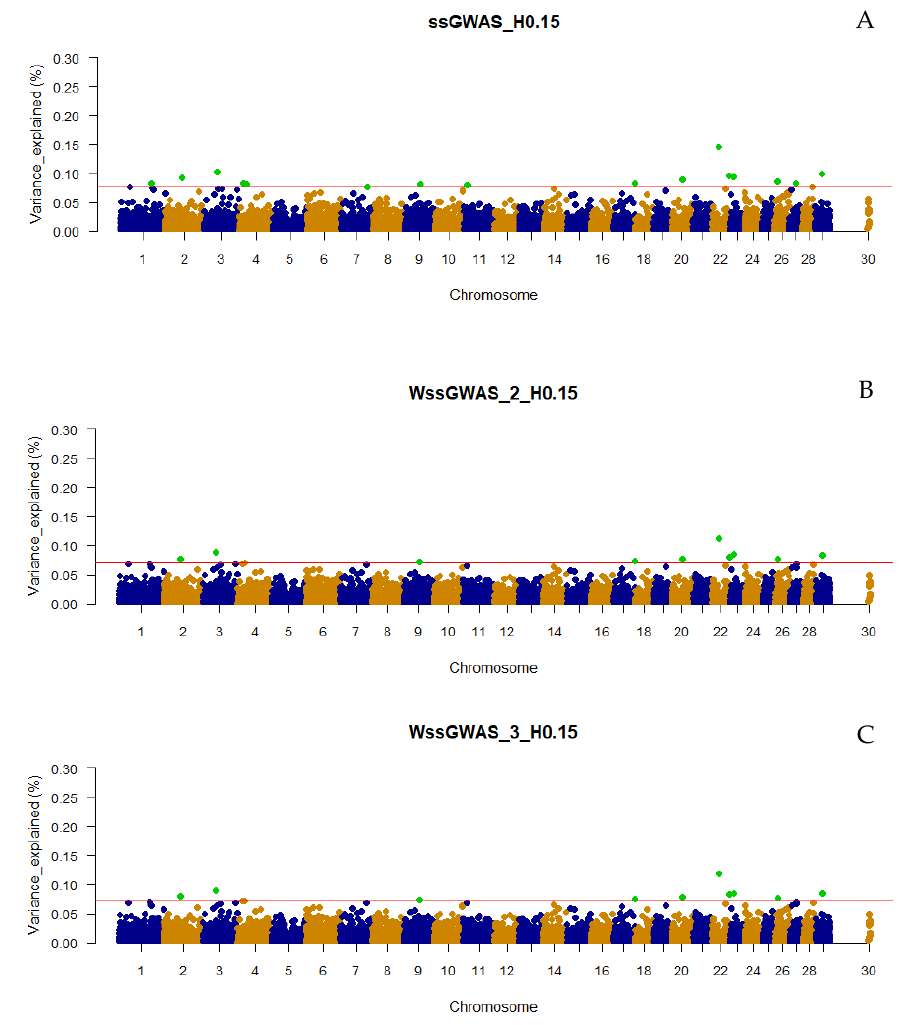
Figure 2. Manhattan plot of the percentage of the total additive genetic variance explained by haplotypes from haploblocks built with a linkage disequilibrium threshold of 0.15 for yearling temperament in American Angus cattle using single-step GWAS (ssGWAS_H0.15; A ) and weighted single-step GWAS in the second (WssGWAS_2_H0.15; B ) and third (WssGWAS_3_H0.15; C ) iterations. Green points highlighted above the red horizontal line are the top 0.001% of markers that explained greater percentages of the total additive genetic variance for YT. The X-chromosome (PAR region) is represented by the chromosome 30.